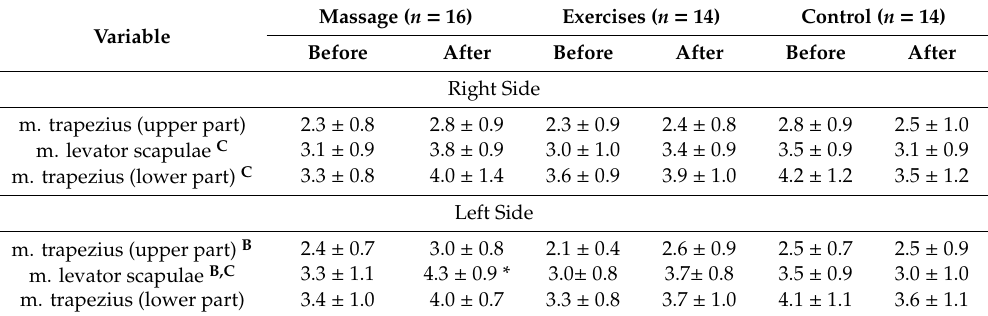
Table 2. Values of pressure sensitivity of selected muscle trigger points on the right and left sides measured in the study groups before and after the program (Mean,